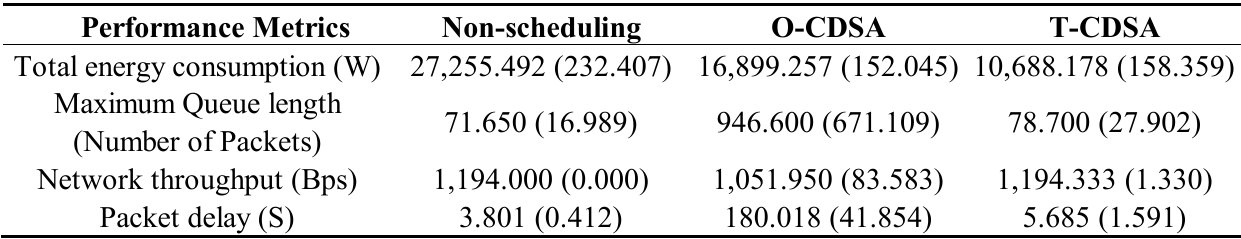
Table 3. Performance comparison of the three